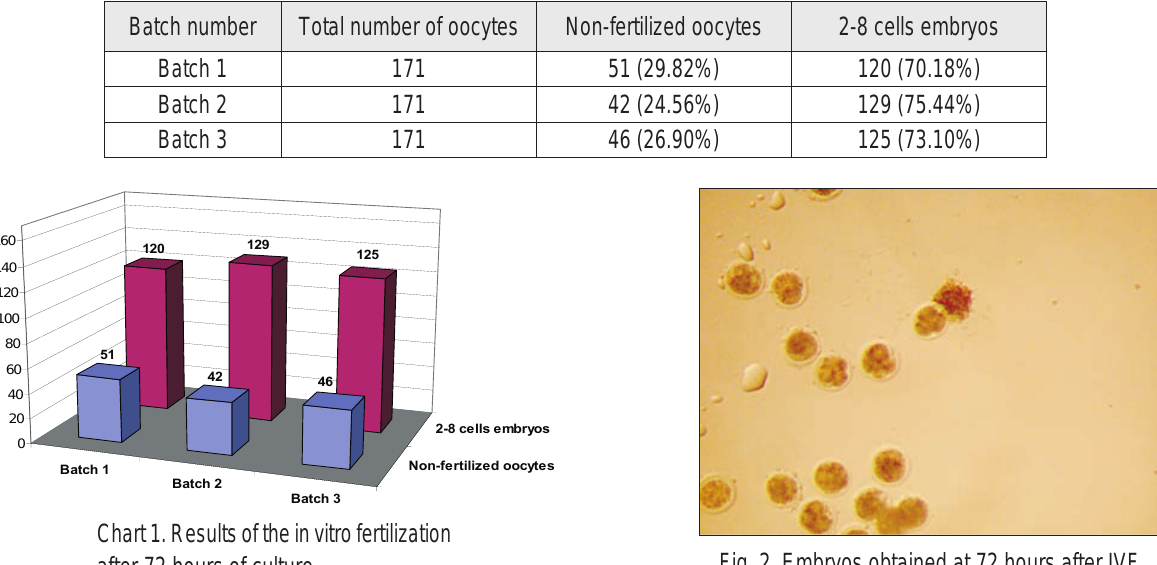
Fig. 2. Embryos obtained at 72 hours after IVF